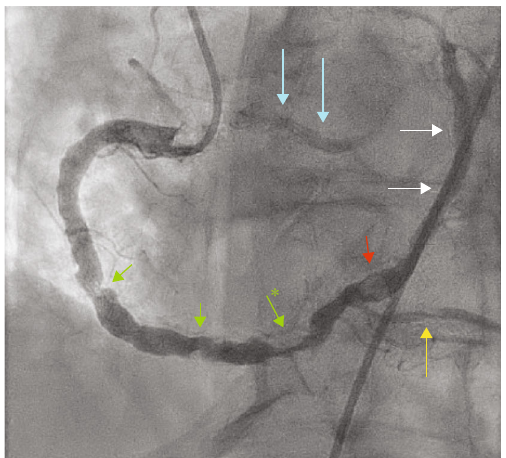
Figure 1: Right coronary angiogram (left anterior oblique 30 ° / cranial 30 ° ) revealing a small anomalous LAD artery (blue arrows), a large ectatic RCA giving rise to the LCx (white arrows), multiple RCA lesions (green arrows) with an 80-90% mid to distal calci fi ed eccentric lesion (green arrow with asterixis), a fi lling defect representing a thrombotic occlusion in the distal RCA (red arrow), and a 70% mid right posterior descending artery concentric lesion (yellow arrow).